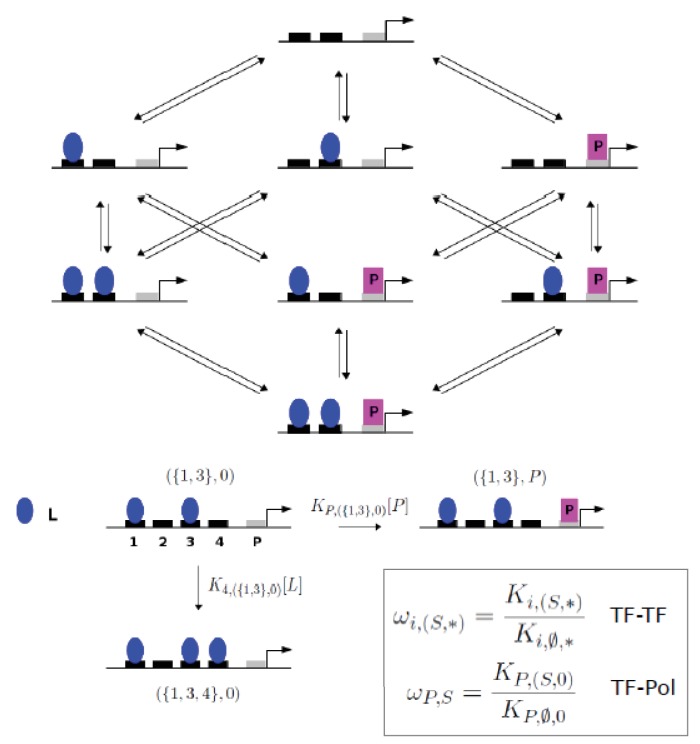
Graph for gene regulation model.(Top) Graph for the gene regulation model with two sites for a transcription factor, L, and a single site for RNA polymerase, P, giving a 2 + 1 model. (Bottom) The set-theoretic notation used for microstates and transition rates at thermodynamic equilibrium is illustrated for 4 + 1 sites, with K denoting association constants and [-] denoting concentration. To fix the level of RNA polymerase, it is assumed that K P,(Ø, 0) [P]=1. (Bottom, inset) Non-dimensional higher-order cooperativities are defined as ratios of association constants.